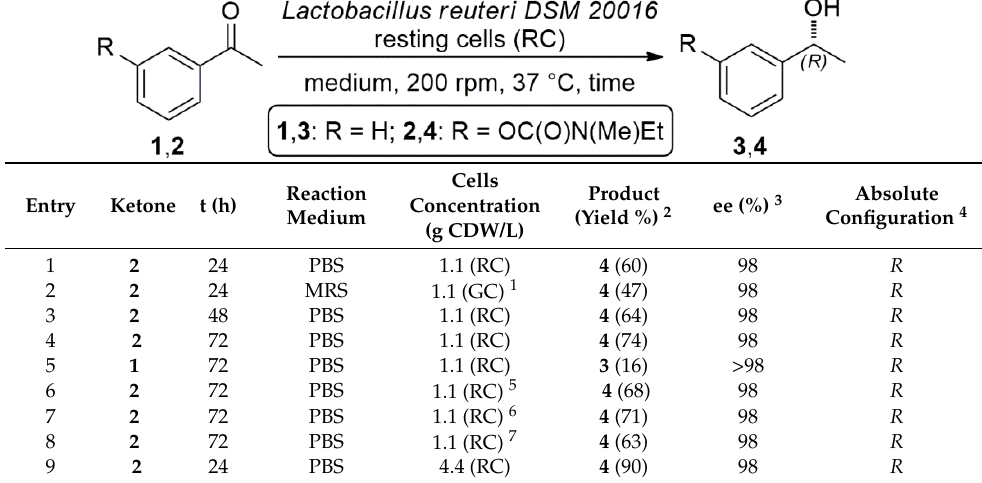
Table 2. Stereoselective reduction of ketones 1 and 2 with Lactobacillus reuteri DSM 20016 whole cells 1 . CDW: cell dry weight.